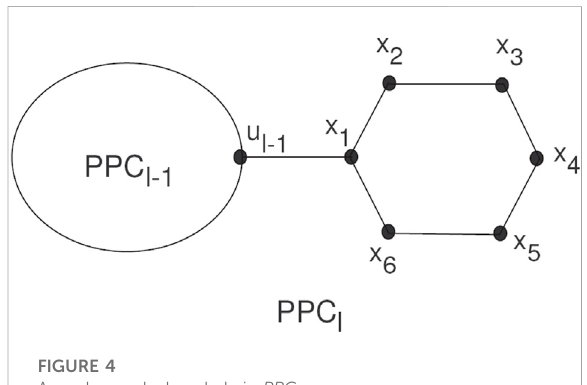
FIGURE 4 A random polyphenyl chain PPC l